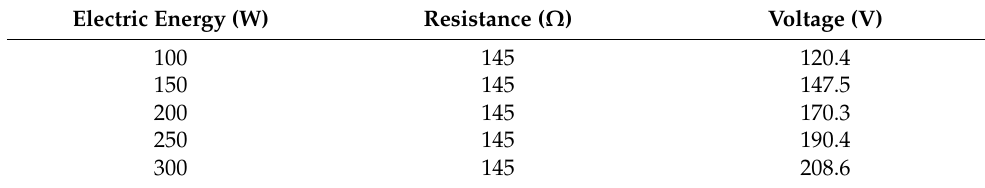
Table 1. Lab test conditions for designing the optimal power consumption of a film heater. Electric Energy